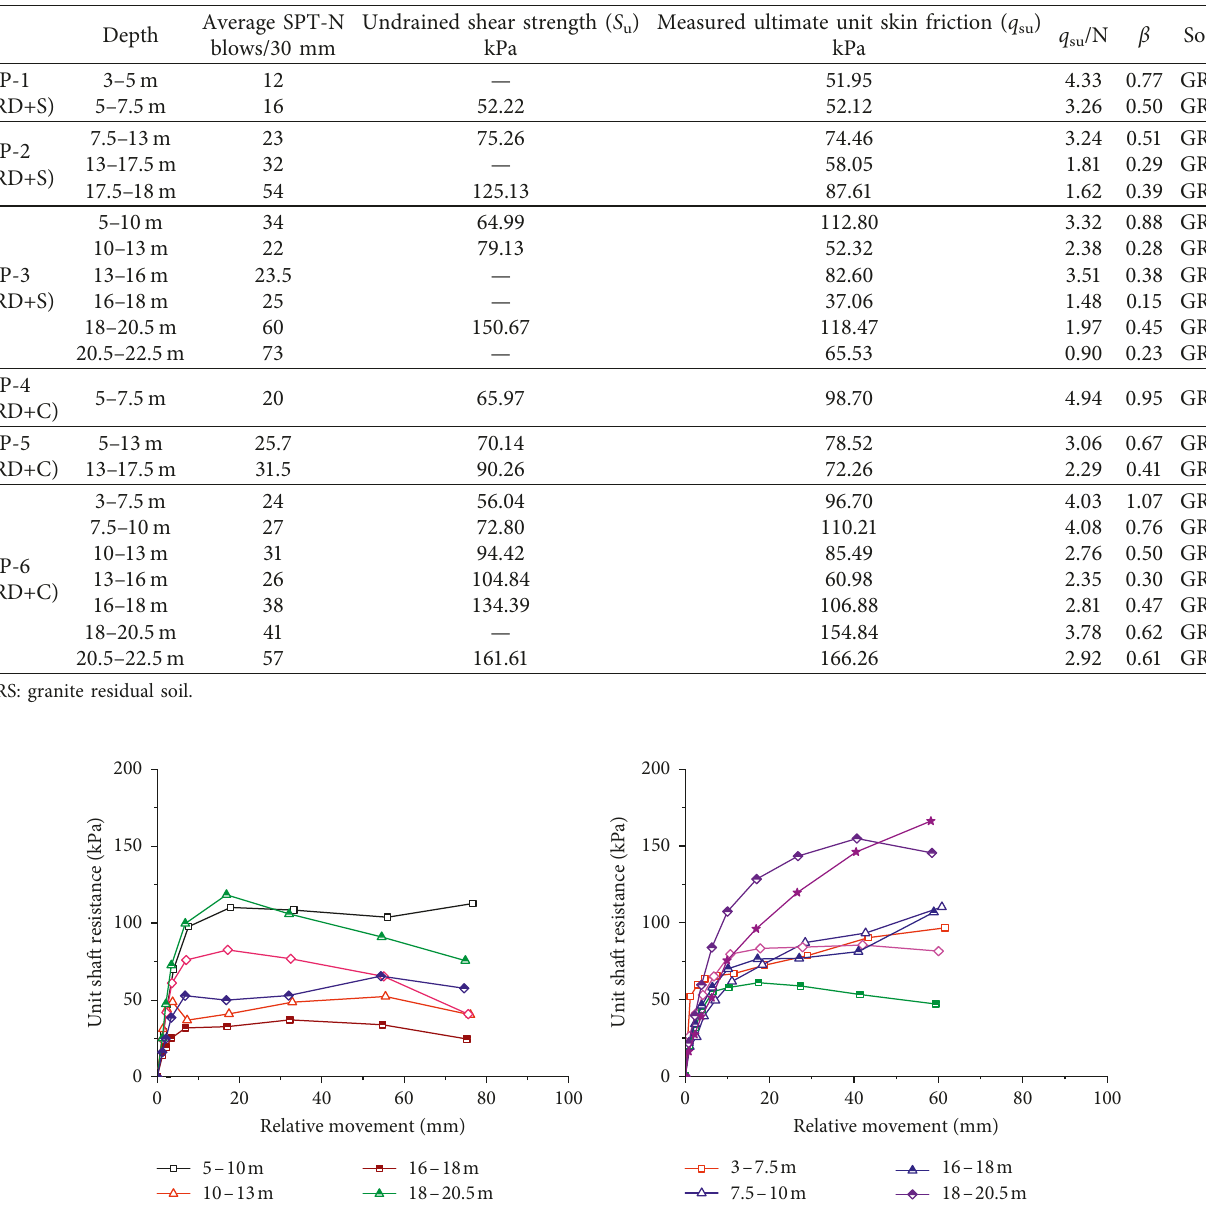
Table 4: Summary of back-analyzed factors for the shaft resistance.